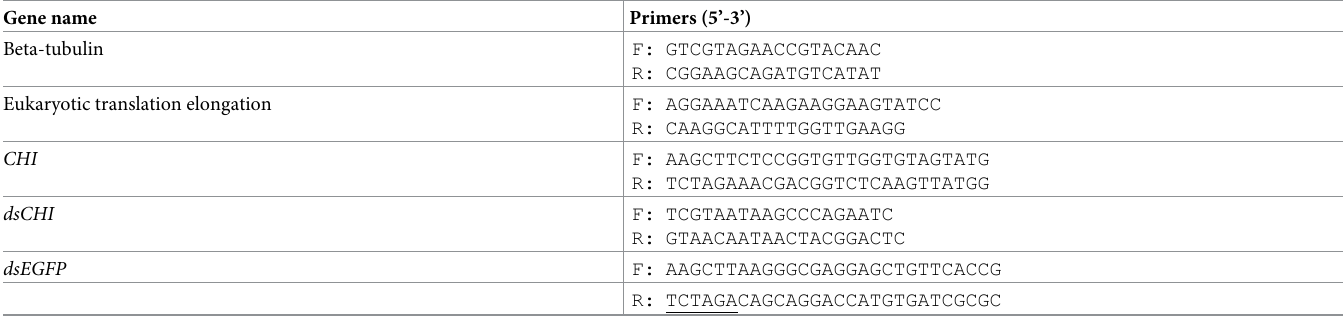
Table 1. List of primers used in the study.